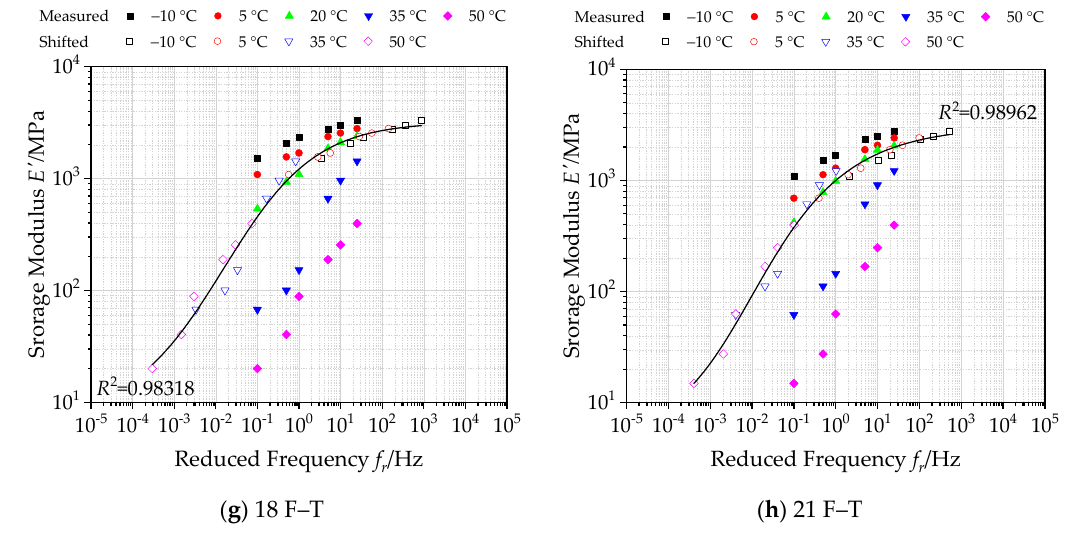
Figure 10. Master curves of storage modulus under various F–T cycles (reference temperature = 20 °C). Table 9. Parameters of master curve functions of storage modulus under various F–T cycles. Parameters of Master